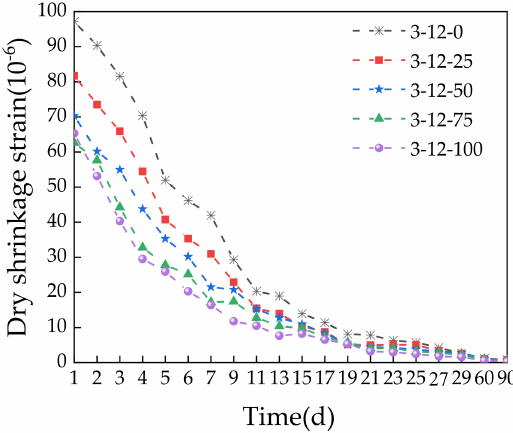
Figure 14. Relationship between the time and dry shrinkage strain.